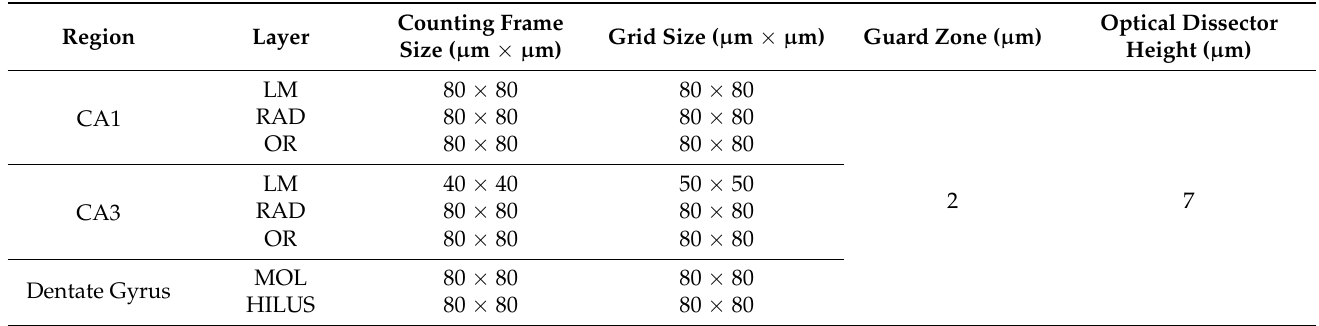
Table 4. Stereological parameters of the quantitative estimate of CA1, CA3, and DG of mice submitted to mastication dysfunction, an enriched environment, and